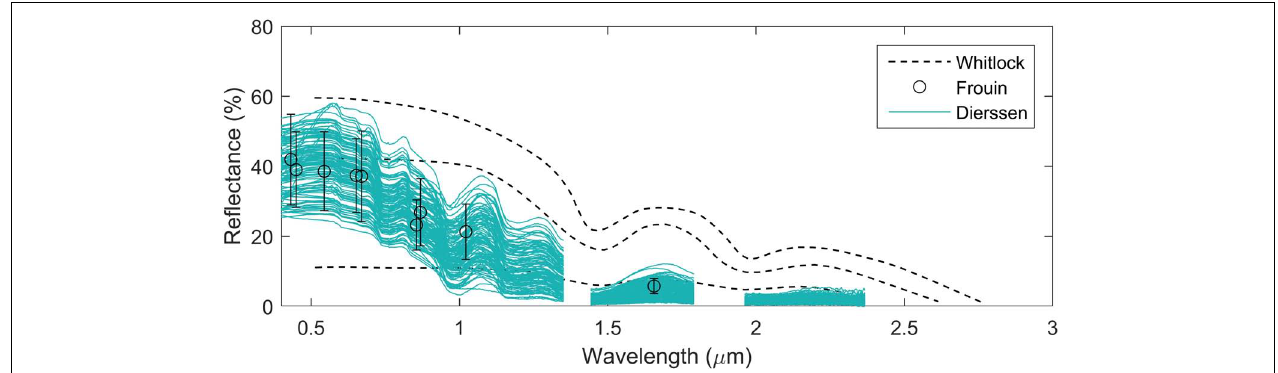
FIGURE 8 | Spectral reflectance of the whitecap of breaking waves measured from visible to short-wave infrared with black dashed lines from Whitlock et al. (1982, Figure 2a) and circles with error bars from Frouin et al. (1996). The different black-dashed lines correspond to different foam samples, with upper and lower curves corresponding to clear water foam patches with multiple- and single-bubble layer, respectively. Cyan lines are new hyperspectral measurements of breaking waves from Dierssen (2019) as part of the PACE project showing the liquid water absorption features at 0.750, 0.980, and 1.150 µ m. The gaps in the measured spectrum correspond to regions where the atmosphere is opaque and downwelling irradiance is too low for a reliable signal.